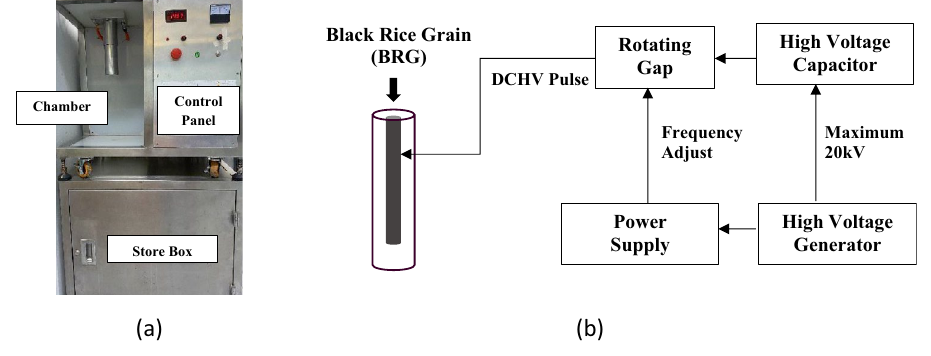
Figure 1. ( a ) PEF equipment and ( b ) schematic overview of PEF treatment